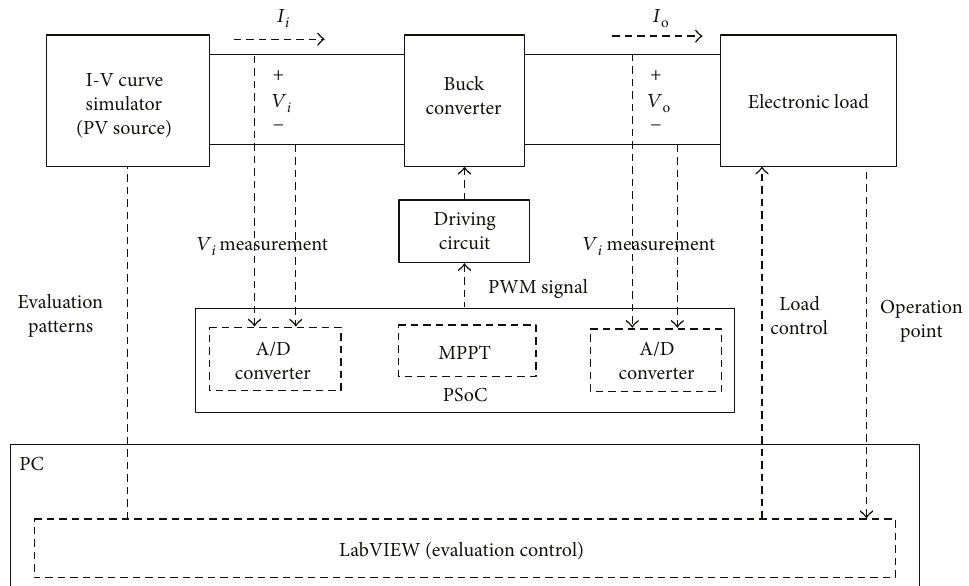
Figure 9: Evaluation system structure. Table 10: Speci fi cations of the buck converter.